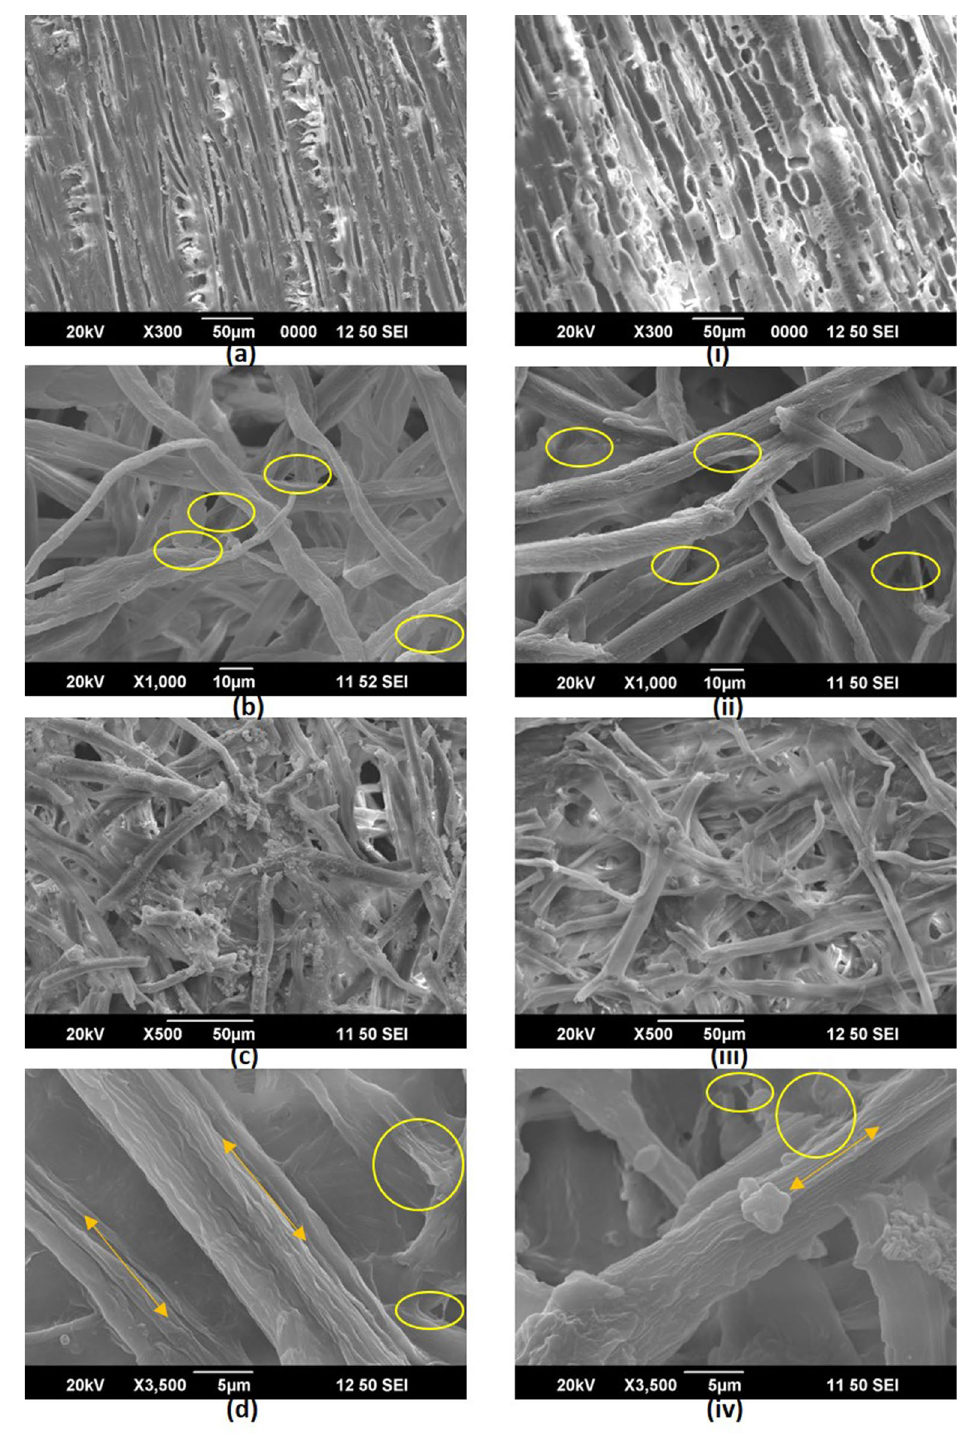
Figure 3. SEM images of ( a and i) untreated fibres; ( b and ii) alkali treated and bleached fibres; ( c , d , iii and iv) oxalic acid treated steam exploded fibres (a-d are eucalyptus samples and i-iv are casuarina